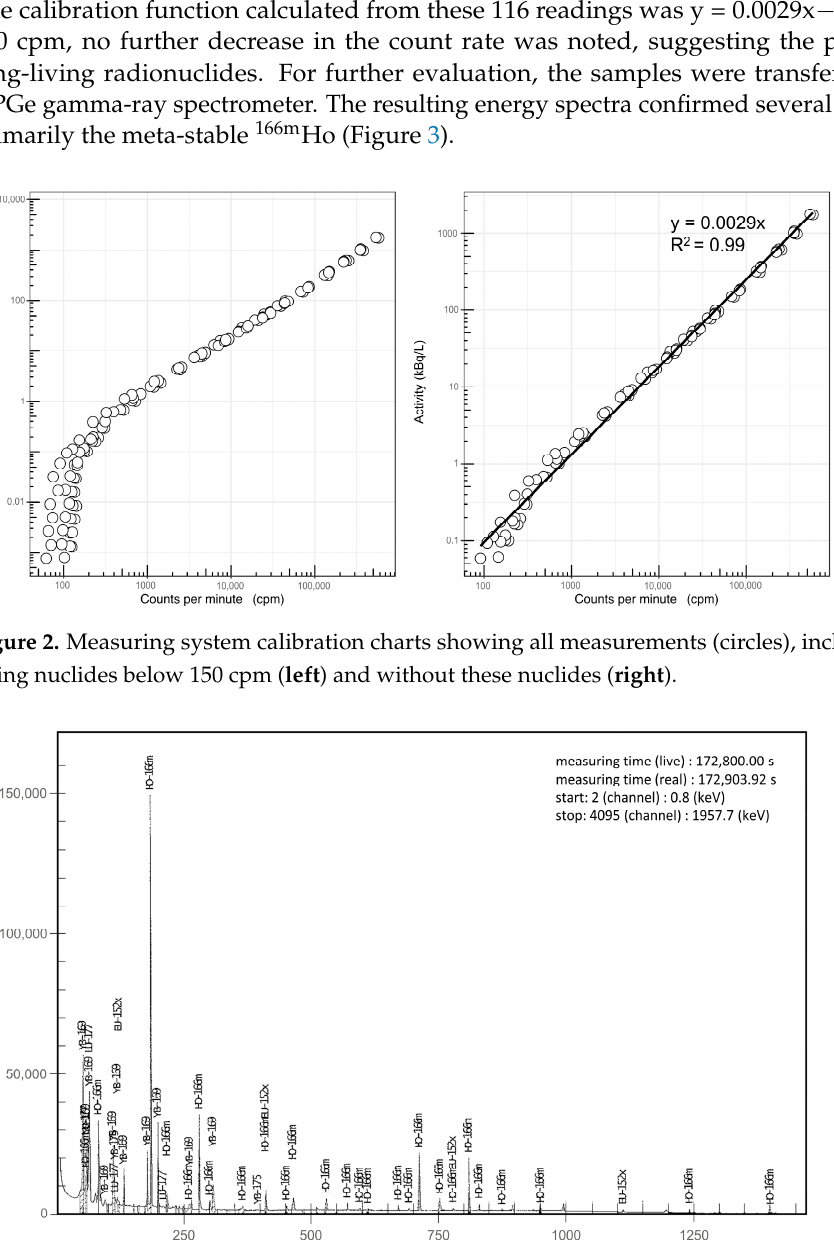
Figure 1. Setup of the whole-body dose rate meter.